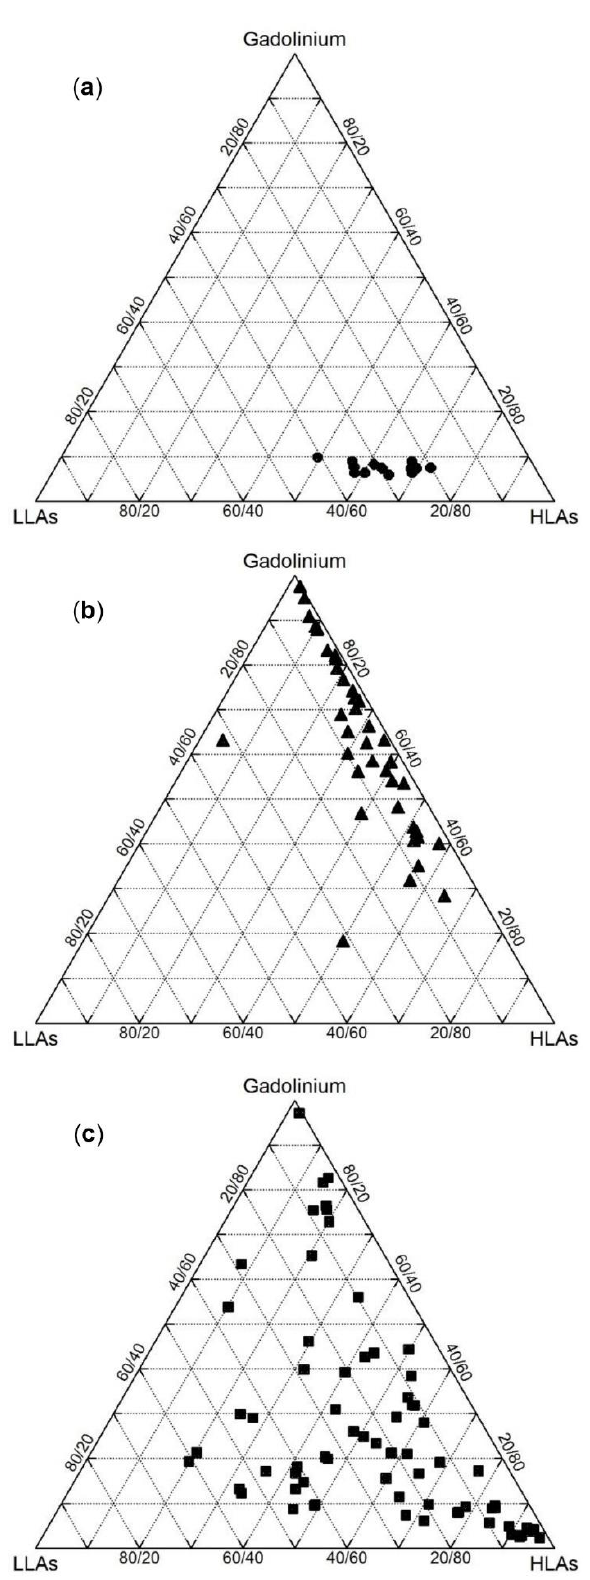
Figure 6. Comparison of LA concentrations (element contents are normalised to MUQ (Mud of Queensland; [87]) in: ( a ) Uncontaminated river waters; ( b ) influents and effluents of WWTPs; ( c ) contaminated river waters. The datasets of the articles listed in Tables 2 and 6 were used. LLAs: La to Eu, HLAs: Tb to Lu